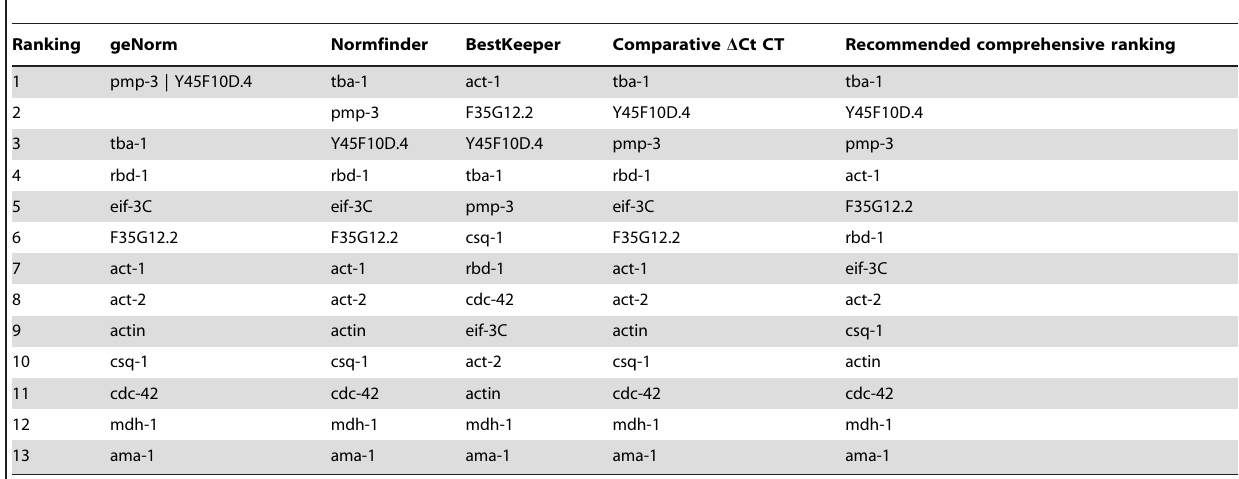
Table 3. The comprehensive rankings of all thirteen candidate reference